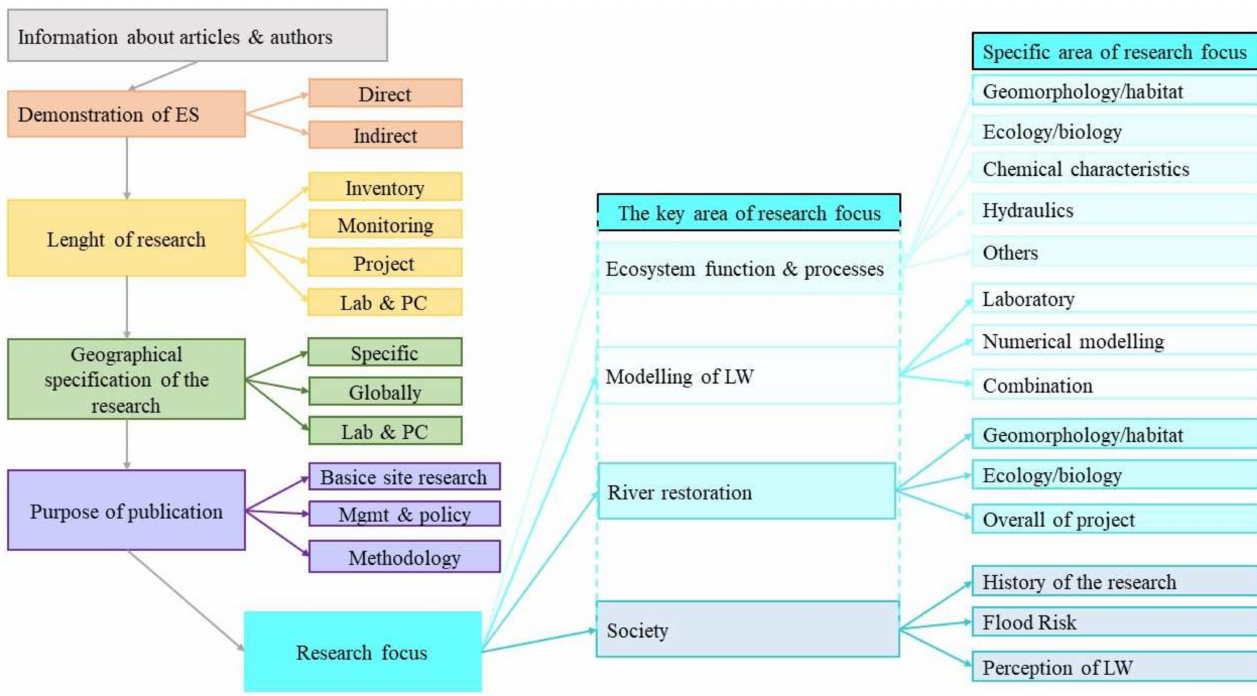
Figure 2. Flow diagram of the process of data extraction from the